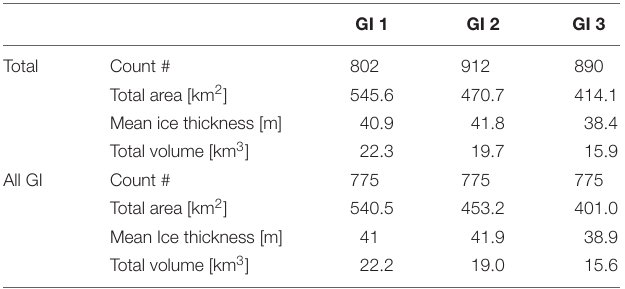
TABLE 3 | Number of investigated glaciers for the total glacier inventory and for all glaciers with outlines covered by all GIs. GI 1 GI 2 GI 3